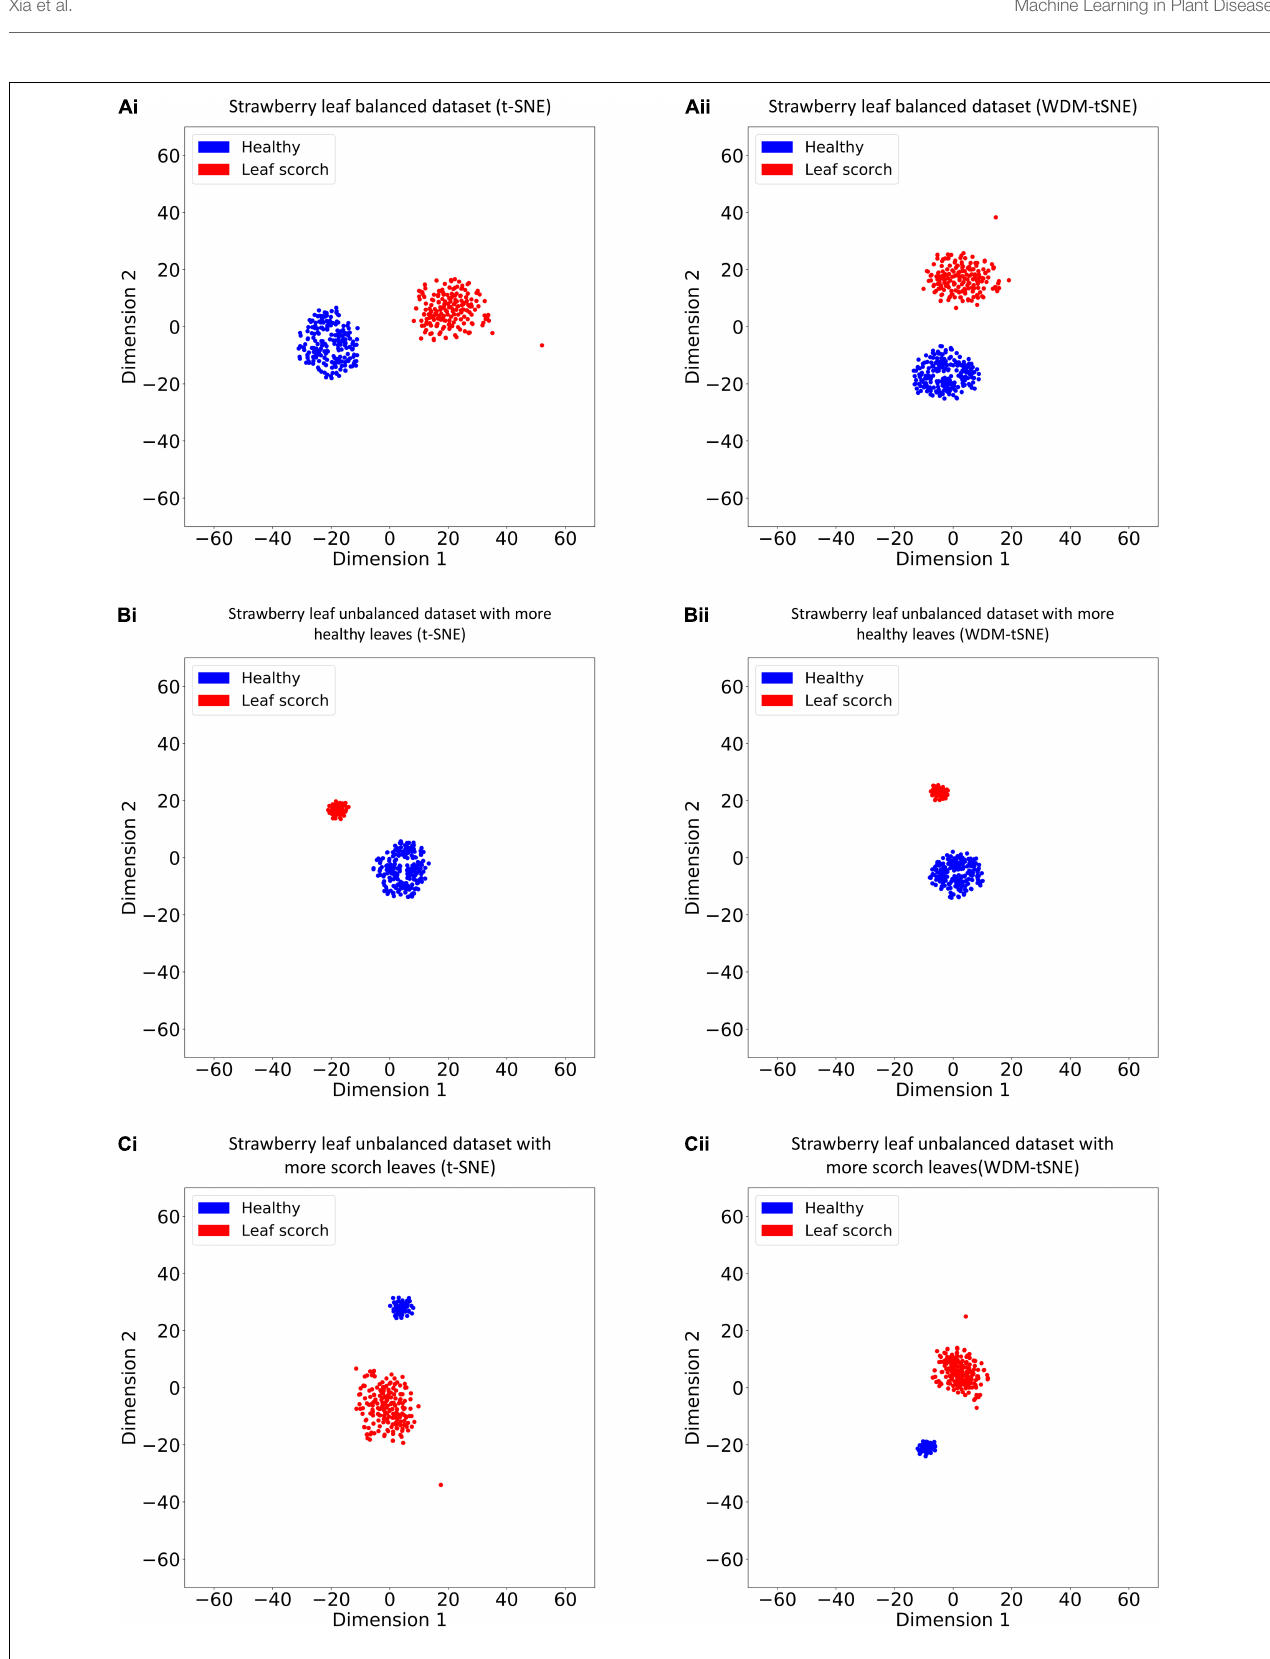
FIGURE 6 | The plots for the (A) balanced or (B–C) unbalanced datasets of strawberry leaf scorch based on (i) t-SNE and (ii) WDM-tSNE. WDM-tSNE, Weighted Distance Metric and the t-stochastic neighbor embedding algorithm.